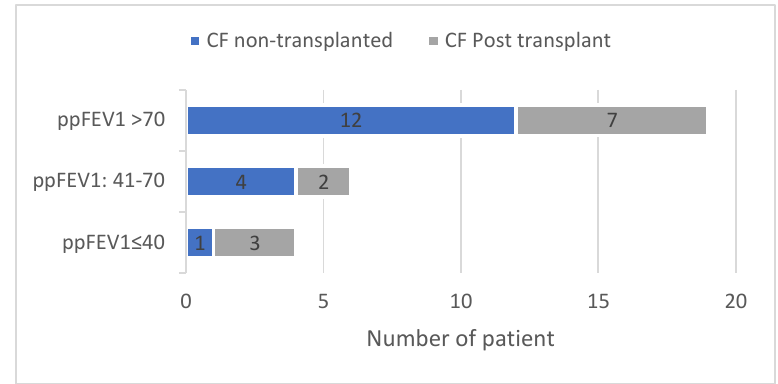
Figure 2. Distribution of baseline lung function in 31 patients with CF at SARS-CoV-2 infection onset. At SARS-CoV-2 infection onset, among the 31 patients, the majority had preserved lung function, 19 patients (65%) having a percent-predicted forced expiratory volume in one second (ppFEV 1 ) that was greater than 70.